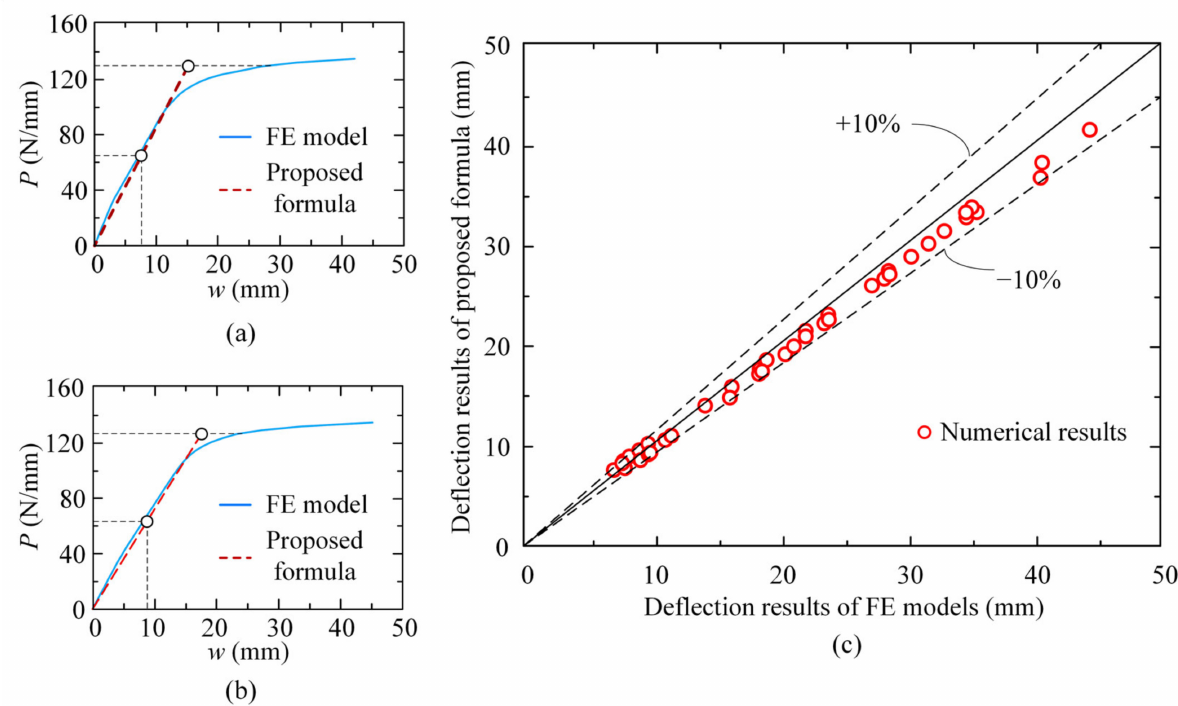
Figure 12. Comparison between the calculation results of the proposed formula and the FE analysis. (( a ) Load − deflection curve of 6-m-span frame at middle span in 1st story; ( b ) Load − deflection curve of 6-m-span frame at side span in 4th story; ( c ) Comparison of deflection results between proposed formula and FE